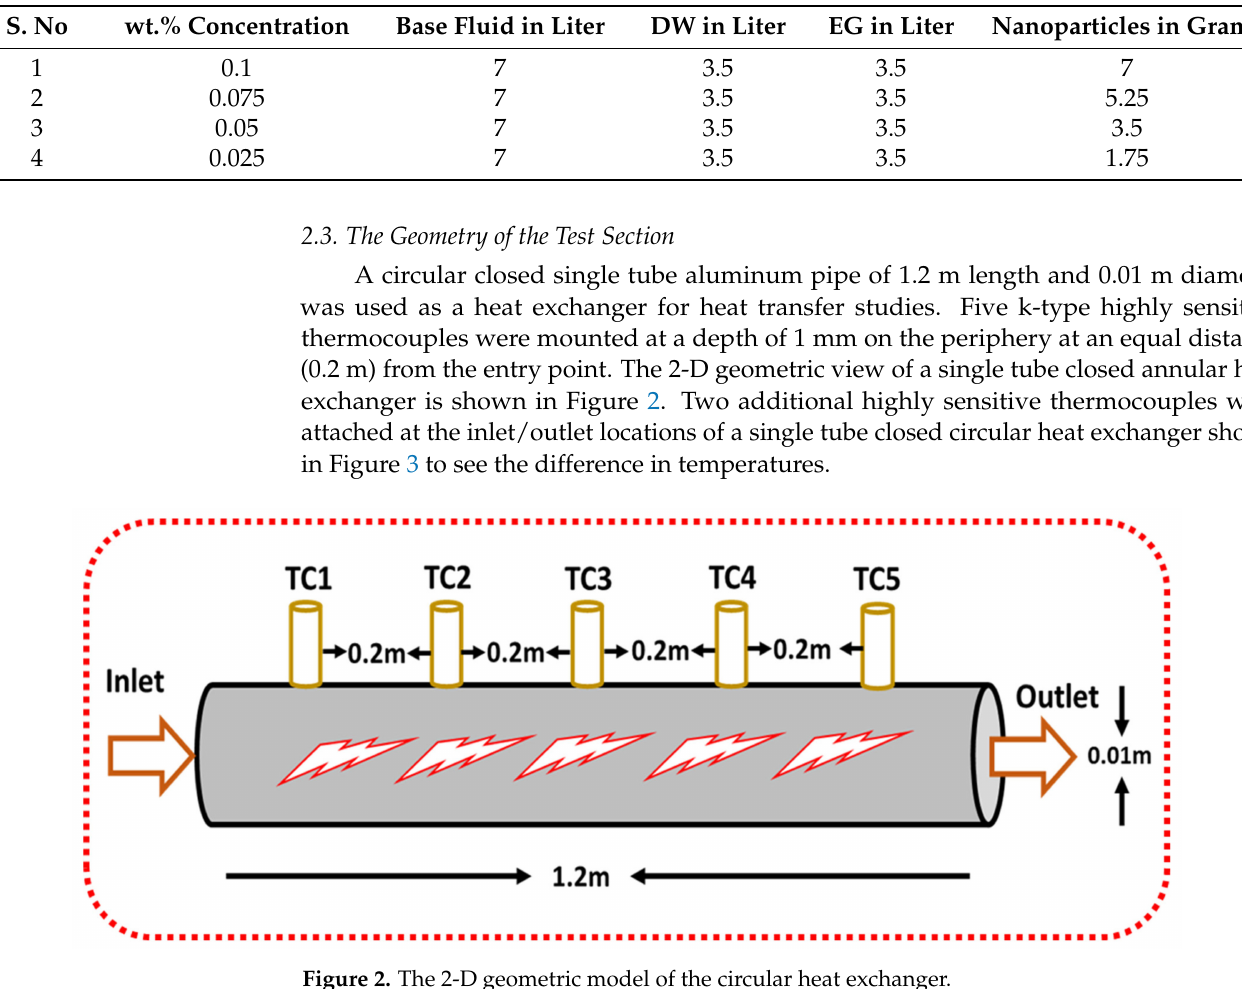
Table 1. Sequential data table for ZnO-EG@DW nanofluids at different concentrations.